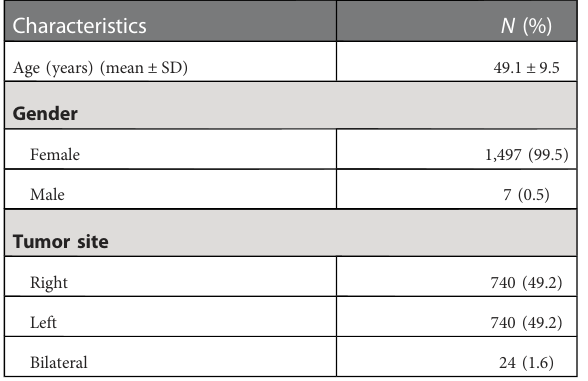
TABLE 1 Patients ’ characteristics ( N =1,504).